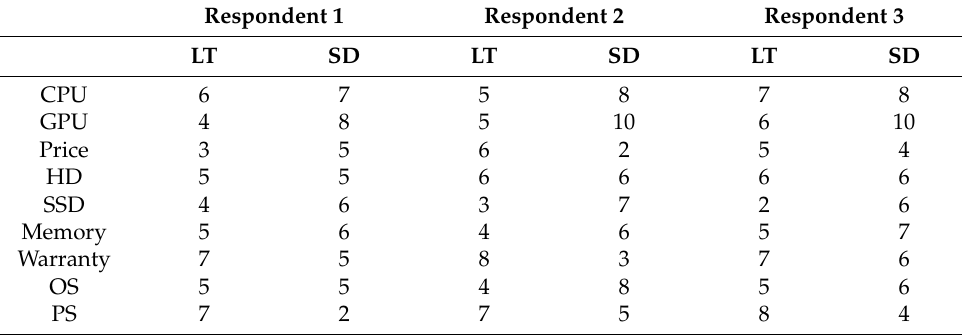
Table 8. Evaluation scores for GPU workstation